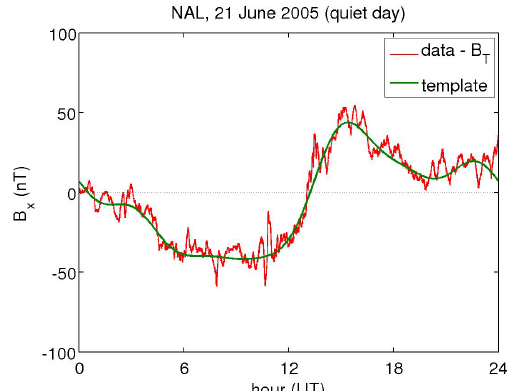
Fig. 7. Red: B x field measured by the magnetometer in Ny-Ålesund (NAL) on 21 June 2005, one of the assigned quiet days, with the long-term baseline subtracted, leaving only the diurnal variation. Green: the template derived from this quiet